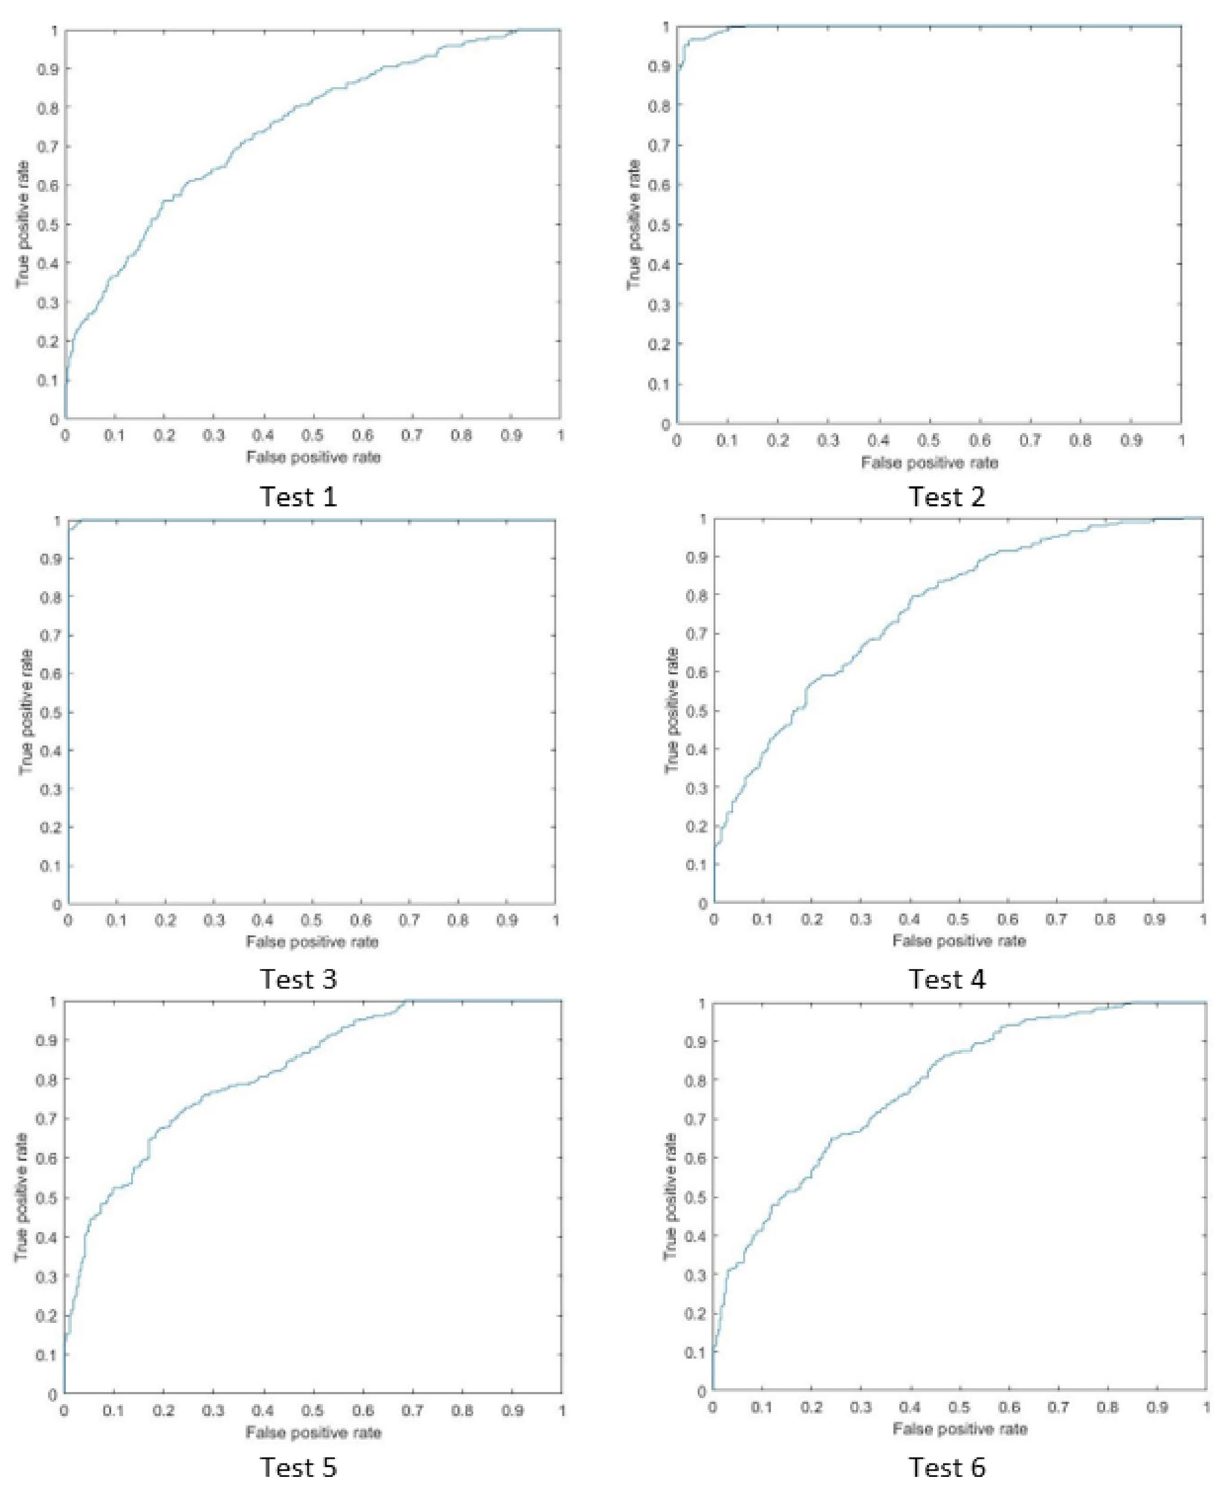
Figure 9. The ROC curve of the first six tests in our proposed